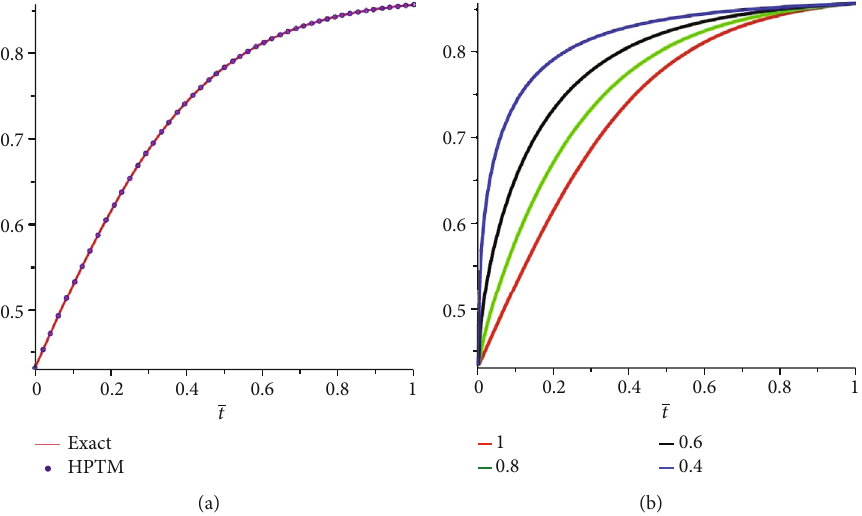
Figure 5: (a) The fi rst graph of actual and analytical solution and (b) the second graph of di ff erent fractional order of β of Case